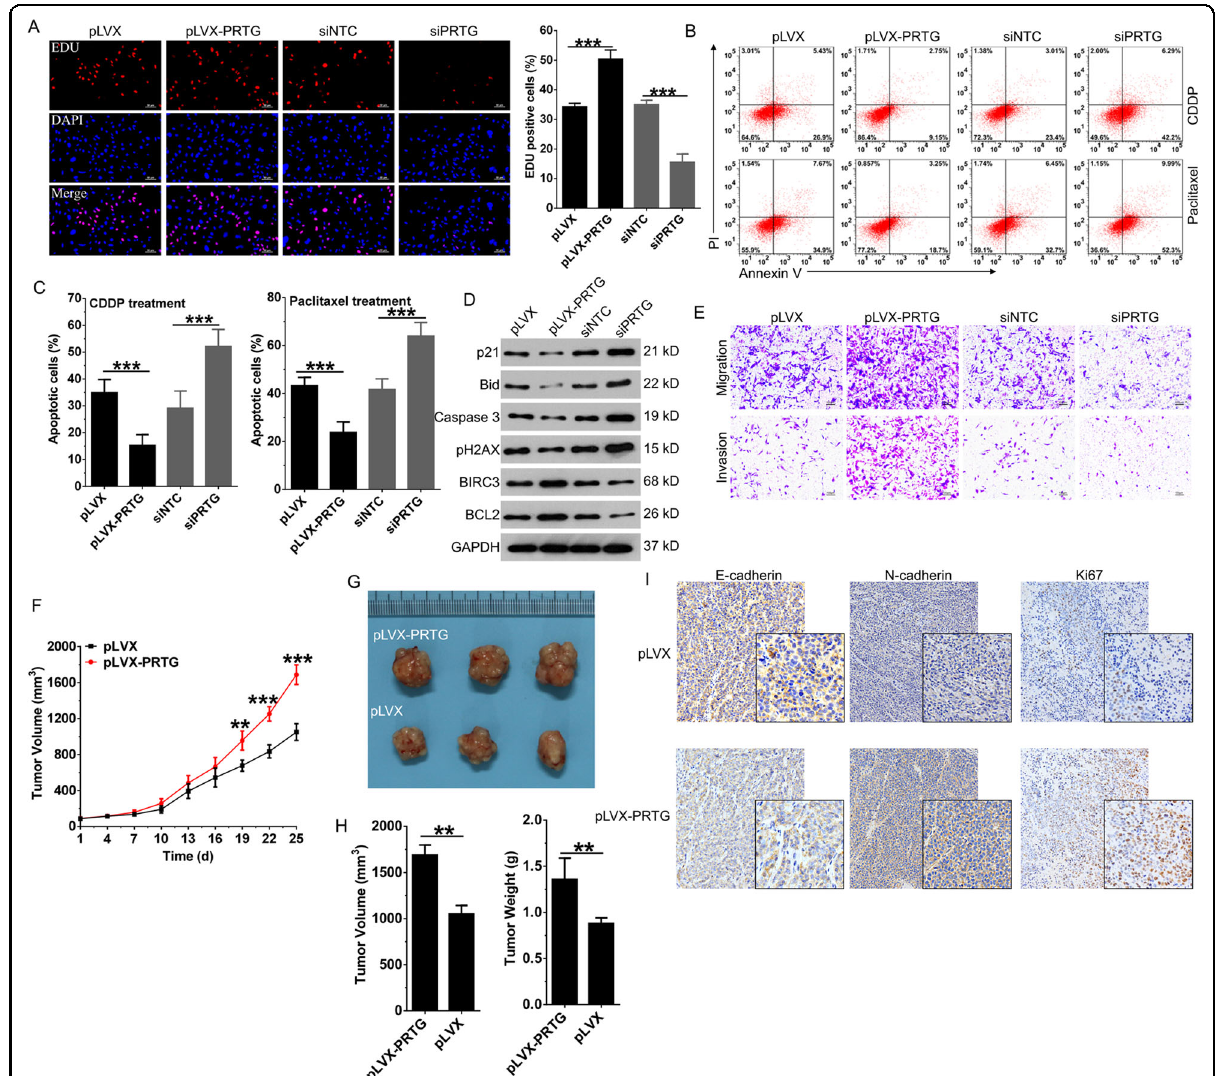
Fig. 2 PRTG plays oncogenic activities in gastric cancer progression. A EdU assay after PRTG stable overexpression or transient knockdown in AGS cells. B Cell apoptosis was detected in PRTG overexpressing or silencing AGS cells after treated with chemotherapy drugs (paclitaxel, 20 nM; CDDP, 5 μ M) for 48 h. C Statistical analysis of apoptosis in AGS cells ( n = 3, related to Fig. 2B). D Western blot was used to detect the effect of PRTG on the expression of apoptosis-related proteins in paclitaxel-treated AGS cells of C . E Transwell assay was used to detect the invasion and migration ability of PRTG overexpressing or silencing AGS cells. F AGS cells stably expressing empty vector (pLVX) or pLVX-PRTG were injected into the nude mice ( n = 12) and tumor volumes were monitored. G Tumor volumes of 3 mice were presented 25 days post inoculation. H Tumor volumes and weights ( n = 12) were measured 25 days post inoculation. I The expression of Ki67, E-cadherin and N-cadherin were detected by IHC. Data were presented as mean ± SD from the three independent replicates. ** P < 0.01; *** P < 0.0001. CDDP, cisplatin; pLVX, empty control pLVX